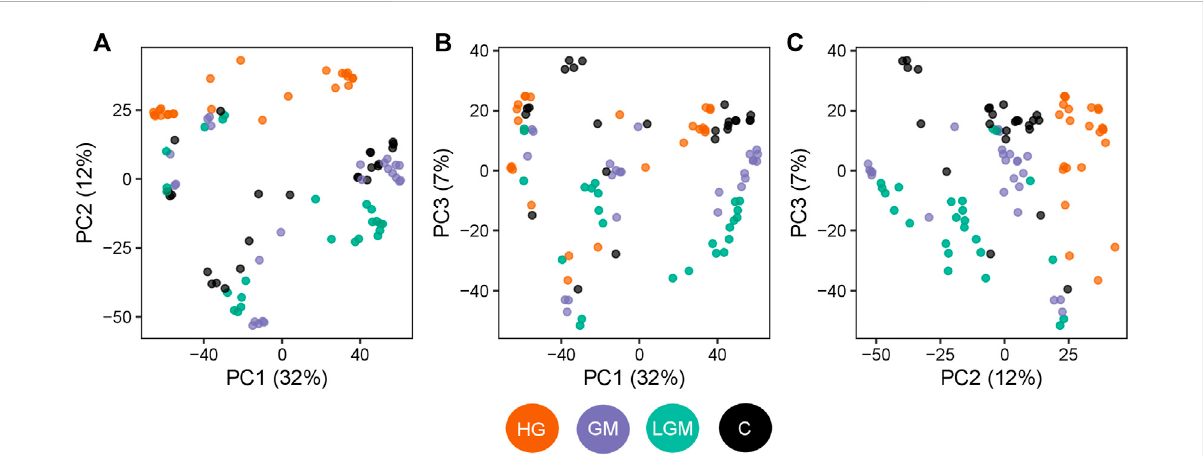
FIGURE 3 Treatment-speci fi c changes in the cell metabolome. Scatterplot of the PCA scores for the three main principal components. The three collectively explain 51% of the variation observed in the metabolome pro fi les. Each point represents one sample and is colored based on the